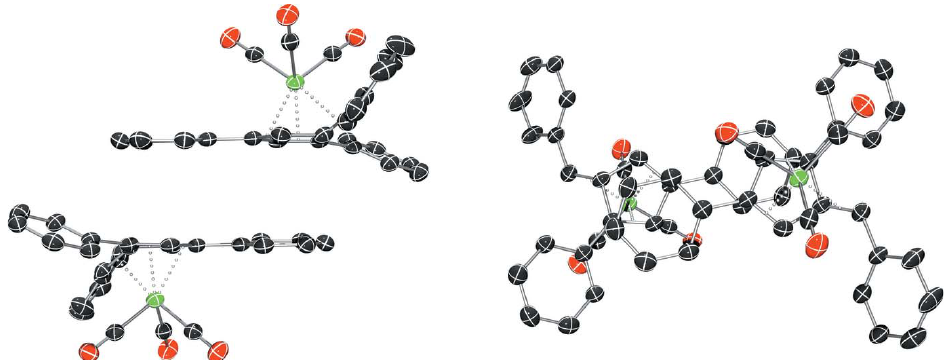
Figure 4 The (cid:2) – (cid:2) stacking arrangement of I , viewed in the plane (left) and normal to the place (right) of the cyclopentadiene-phenyl rings. Displacement ellipsoids are shown at the 50% probability level. Hydrogen atoms have been omitted for clarity.